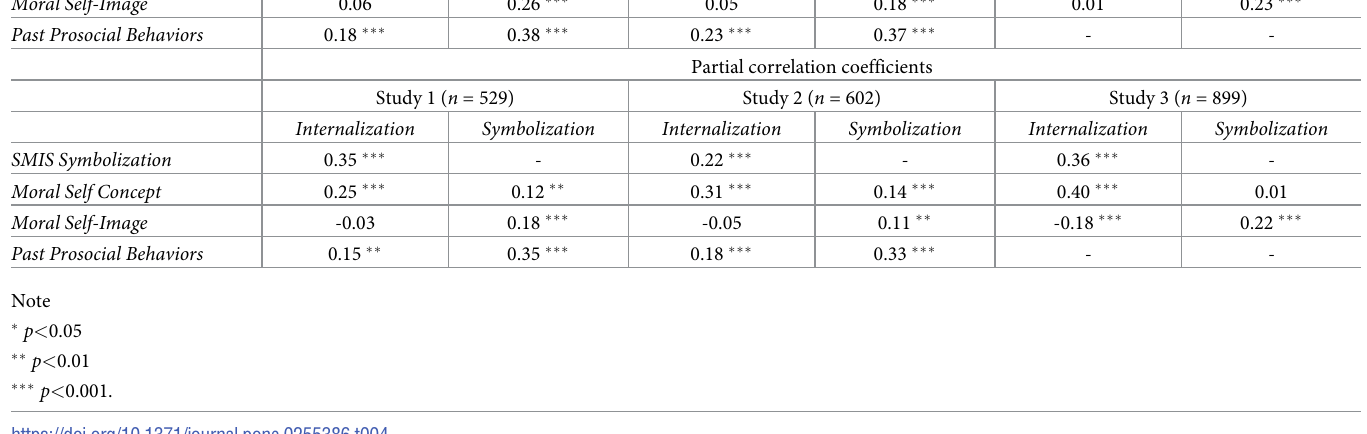
Study 2 was conducted on the sample of 602 participants to confirm the factor structure on a more balanced sample. The descriptive statistics of the sample are given in Table 1. In order to assess dimensionality, PA and EGA were conducted leading to detection of two main dimen- sions consisting of the same items as in Study 1 (S1 and S2 Figs). Next, CFA of SMIS items was conducted resulting in poorly fitting simple structure model (Model 1: RMSEA = 0.09, 90%CI: 0.08–0.11, AIC = 16213.10, BIC = 16349.50, CFI = 0.91, TLI = 0.88). Following item contents and MI we added covariance of items 9 and 10, which significantly improved fit (Model 2: LR test: χ 2 (1) = 83.62 p < 0.001, RMSEA = 0.07, 90%CI 0.06–0.08, AIC = 16131.47,